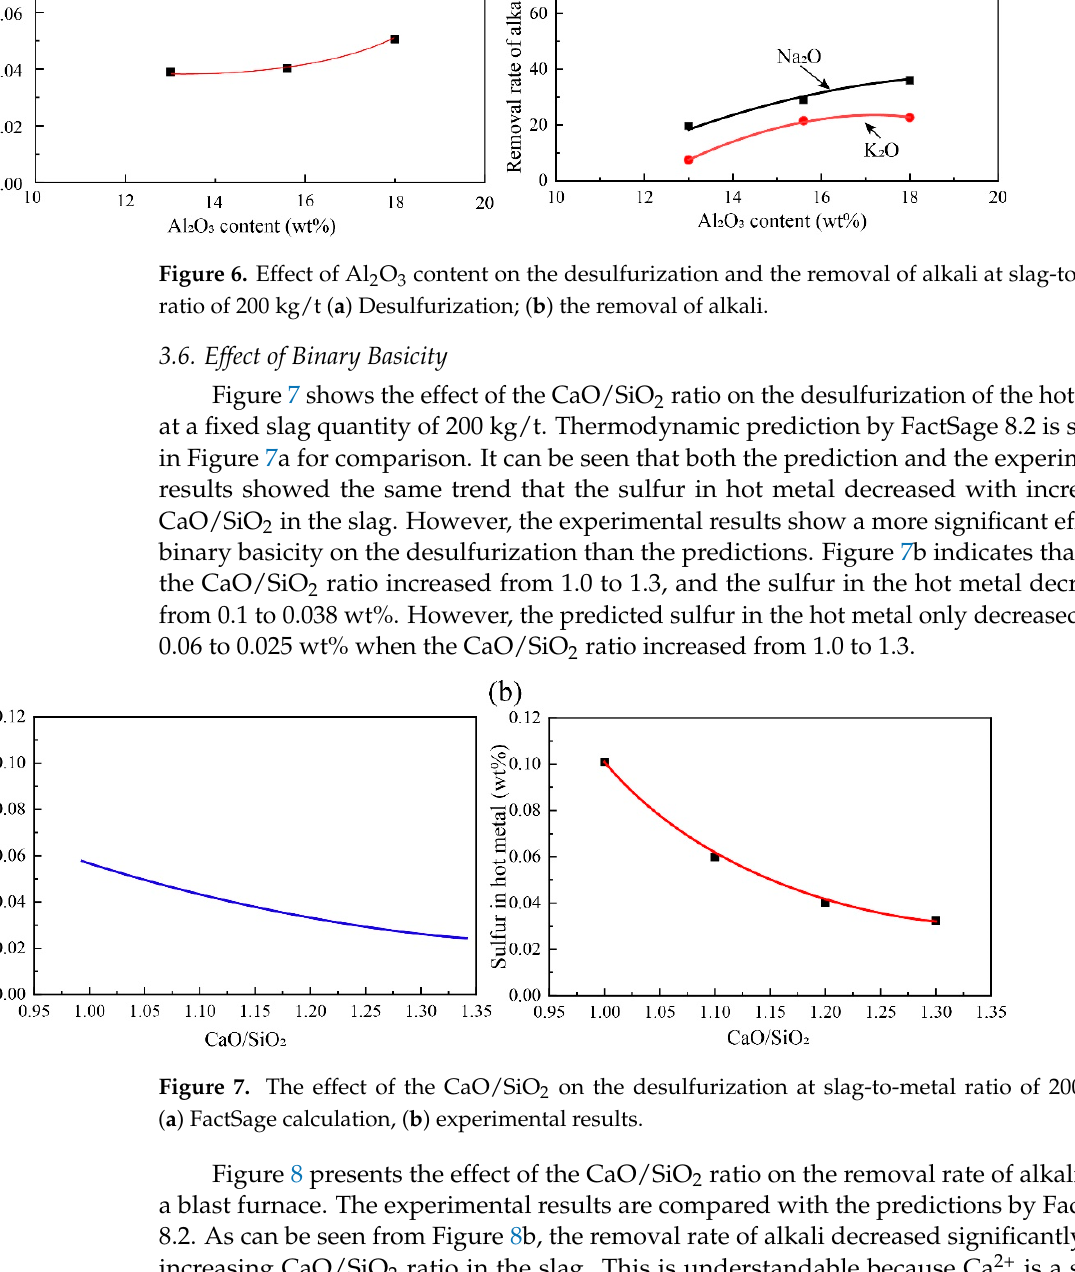
Figure 8. Effect of the CaO/SiO 2 ratio on the removal of alkali at slag-to-metal ratio of 200 kg/t, ( a ) FactSage calculation, ( b ) experimental results. 3.7. Applications The desulfurization of the hot metal and the removal of alkali from the blast furnace were related not only to the metal-slag reaction but also to the sulfur and alkali loads to the blast furnace. The experimental technique used in the present study closely simulated the blast furnace conditions by considering the reaction between the sulfur-containing metal and the alkali-containing slag. However, it was shown in the present study that the metal-slag reaction under the laboratory conditions did not reach equilibrium. The sul- phide capacity or desulfurization ability was usually reported to evaluate the ability of a BF slag to absorb sulphur which was an equilibrium property [9–15]. Desulfurization abil- ity is the ratio of the sulfur-in-slag to the sulfur-in-metal after the equilibrium reaction. It was reported that desulfurization ability of the synthetic slag was in the range of 15–30 at